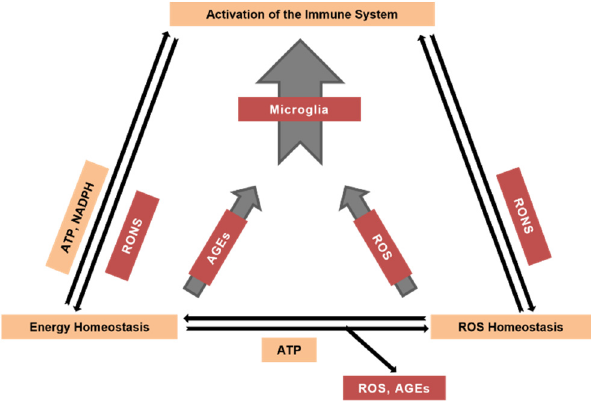
Figure 2. The interplay between the energy/ROS homeostasis and the activation of the brain’s immune system during aging. RONS, reactive oxygen/nitrogen species.